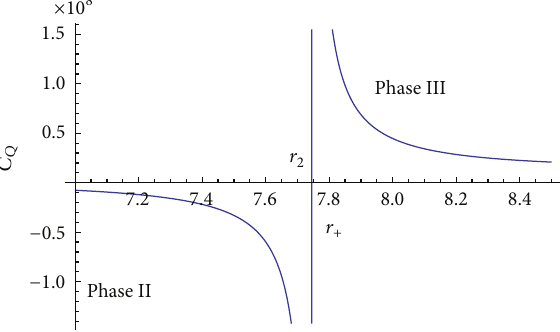
Figure 8: Plot of specific heat ( 𝐶 𝑄 ) against horizon radius ( 𝑟 + ), for 𝛼 󸀠 = 1.0 , 𝑄 = 5 , and 𝑏 = 0.5 at the critical point 𝑟